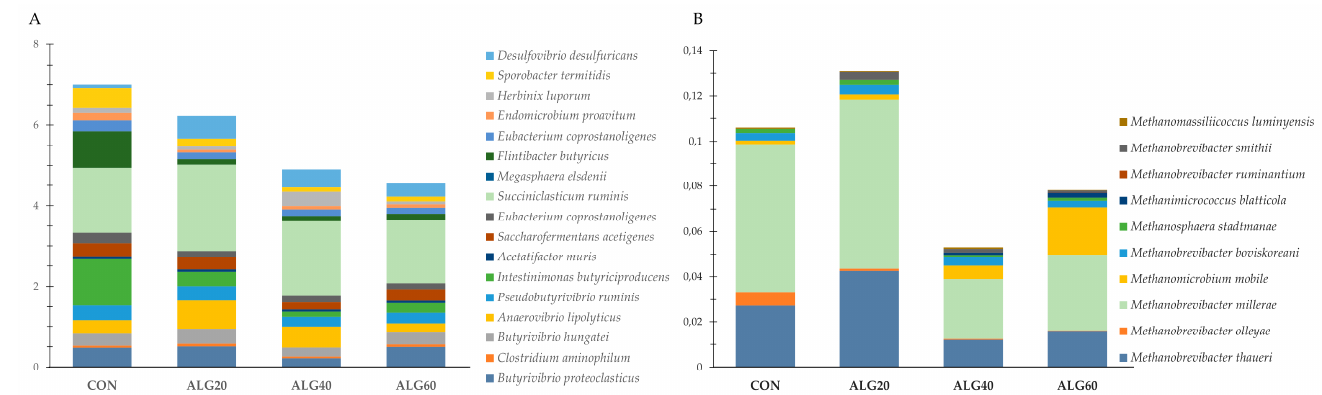
Figure 7. Abundances of ( A ) influential rumen species, ( B ) and methanogenic archaea in the four dietary treatments (CON, ALG20, ALG40, and ALG60) within the two sampling times (20th and 40th days) illustrated in clustered stacked columns. CON = control concentrate without microalgae ( Schizochytrium spp.); ALG20 = CON with 20 g/Kg Schizochytrium spp.; ALG40 = CON with 40 g/Kg Schizochytrium spp.; ALG60 = CON with 60 g/Kg Schizochytrium spp.